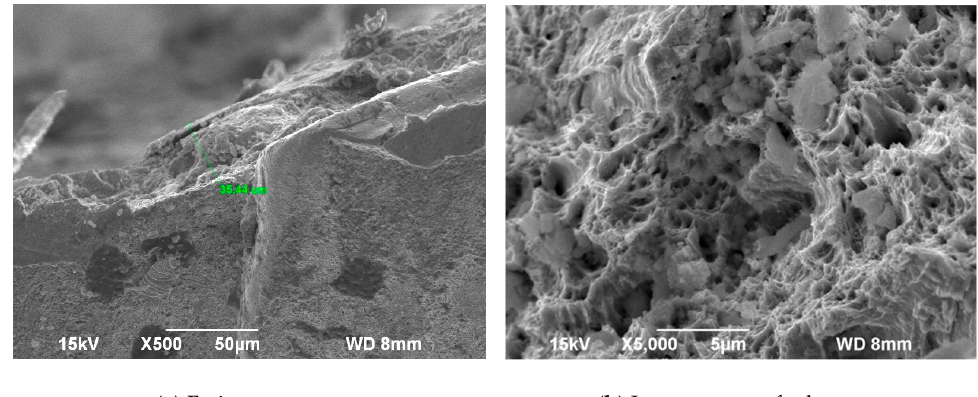
Figure 12. GJX3y fatigue fracture morphology.